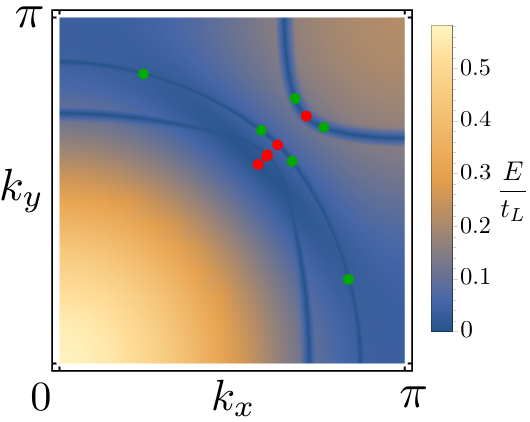
Figure 7: The momentum dependent energy gap E ( q ) for the full model. The semi-Dirac nodes (green) and the Dirac nodes (red) are also shown. The splitting of the Dirac nodes = k along k is too small to be visible in the plot. The tight-binding parameters are described x y in the text. For the tunneling amplitudes we have used values A = 0.68 and B = 0.44.